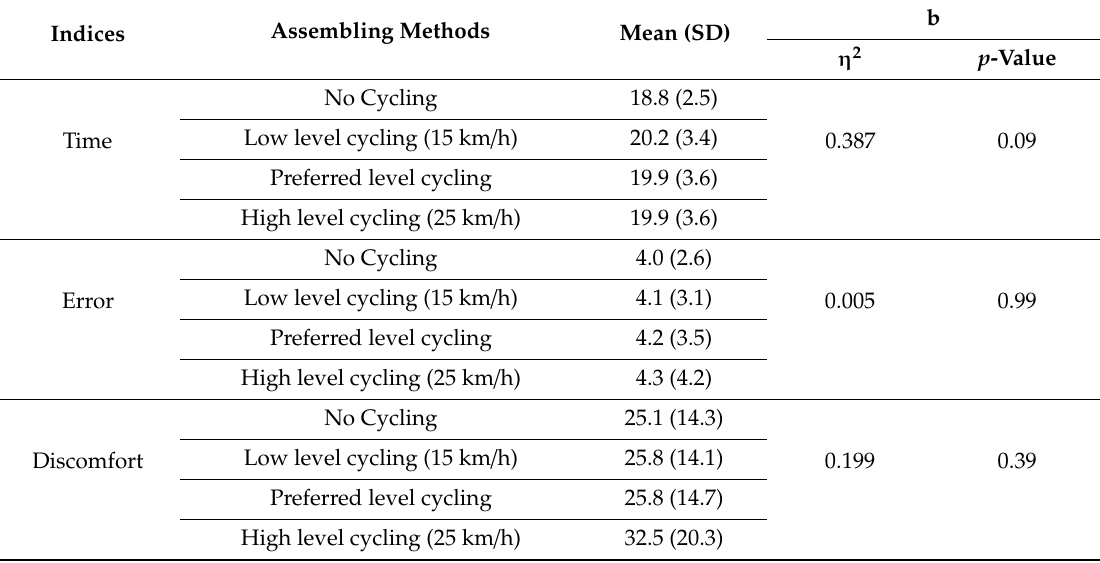
Table 1. Mean (standard deviation) for time, discomfort, and